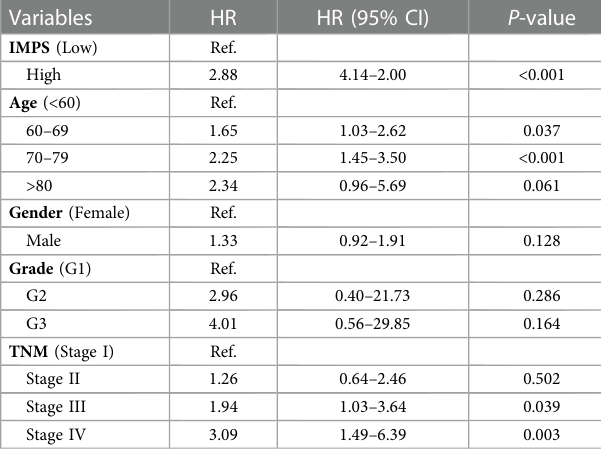
TABLE 3 Multivariate Cox analysis of IMPS and clinical features for gastric cancer prognosis.